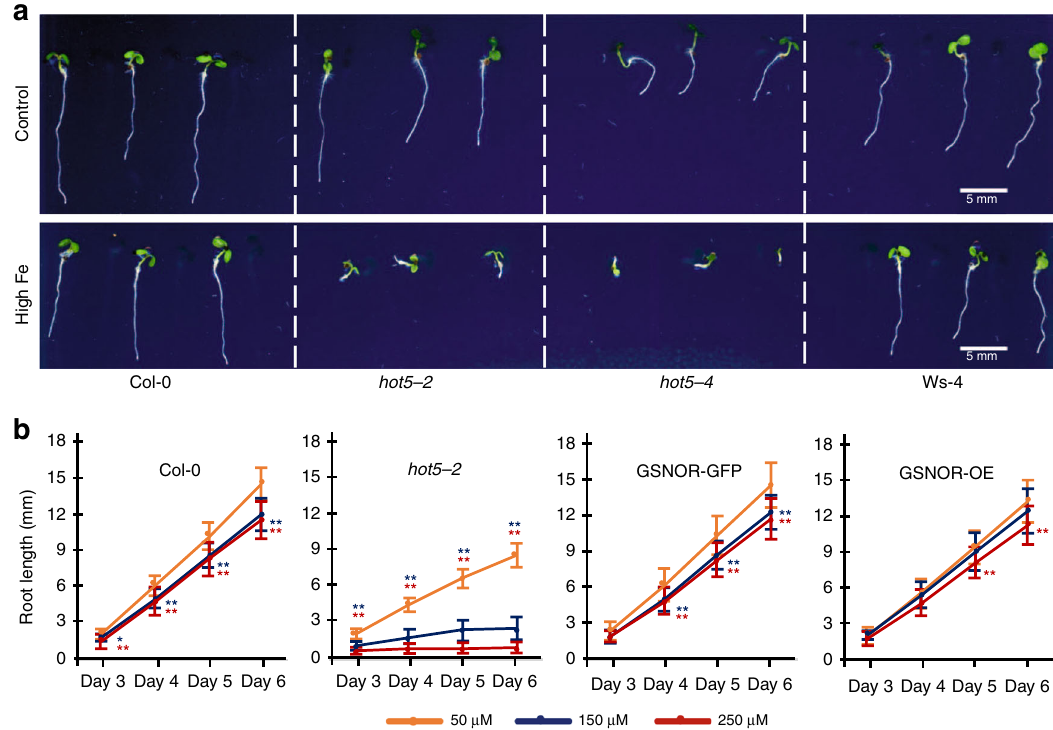
Fig. 3 GSNOR is required for root tolerance to high Fe. a Seedlings of gsnor knockout mutants ( hot5-2 and hot5-4 ) and the respective wild-type (Col-0 and Ws-4) upon high Fe (250 µ M) treatment for 6 days. Scale bar, 5 mm. b Mean root length of wild-type (Col-0), gsnor mutant ( hot5-2 ), complemented line ( GSNOR-GFP ), and over-expression ( GSNOR-OE ) line. Error bars: standard deviation. n = 15 biologically independent samples. Asterisk * and ** represent the signi fi cant differences between high Fe (150 µ M Fe in blue asterisk, 250 µ M Fe in red asterisk) and the control as determined by Student ’ s t -test at p -value < 0.05 and 0.01, respectively. The source data of Fig. 3b are provided in a Source Data fi